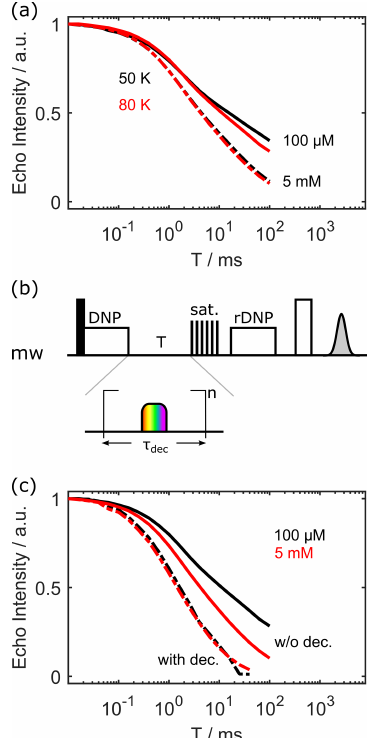
Figure 5. Panel (a) outlines the influence of the electron spin con- centration on the proton polarisation decay. Panel (b) shows the se- quence to investigate the effect of electron decoupling during the waiting time T . A chirp pulse inverts the electron spins every τ dec . This is repeated n = T/τ dec times. Panel (c) visualises the effect of electron decoupling. Solid lines denote that no decoupling was used during time T , and dashed lines denote that the electron spins were inverted every τ dec = 30µs with an adiabatic chirp pulse for 100µM OX063 at